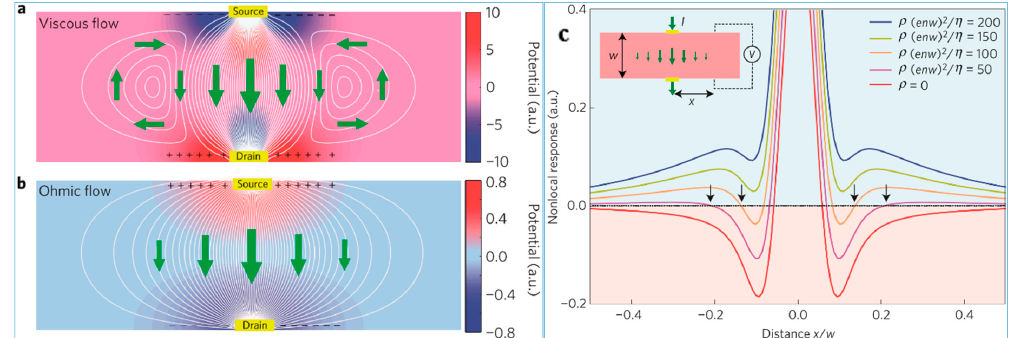
Figure 2. Current streamlines and potential map for viscous and ohmic flows. White lines show current streamlines, colors show electrical potential, and arrows show the direction of current. ( a ) Mechanism of a negative electrical response: viscous shear flow generates vorticity and a backflow on the side of the main current path, which leads to charge buildup of the sign opposing the flow and results in a negative nonlocal voltage. ( b ) In contrast, ohmic current flows down the potential gradient, producing a nonlocal voltage in the flow direction. ( c ) Nonlocal response for different resistivity-to-viscosity ratios, ρ / η [33]. Copyright 2016, Springer